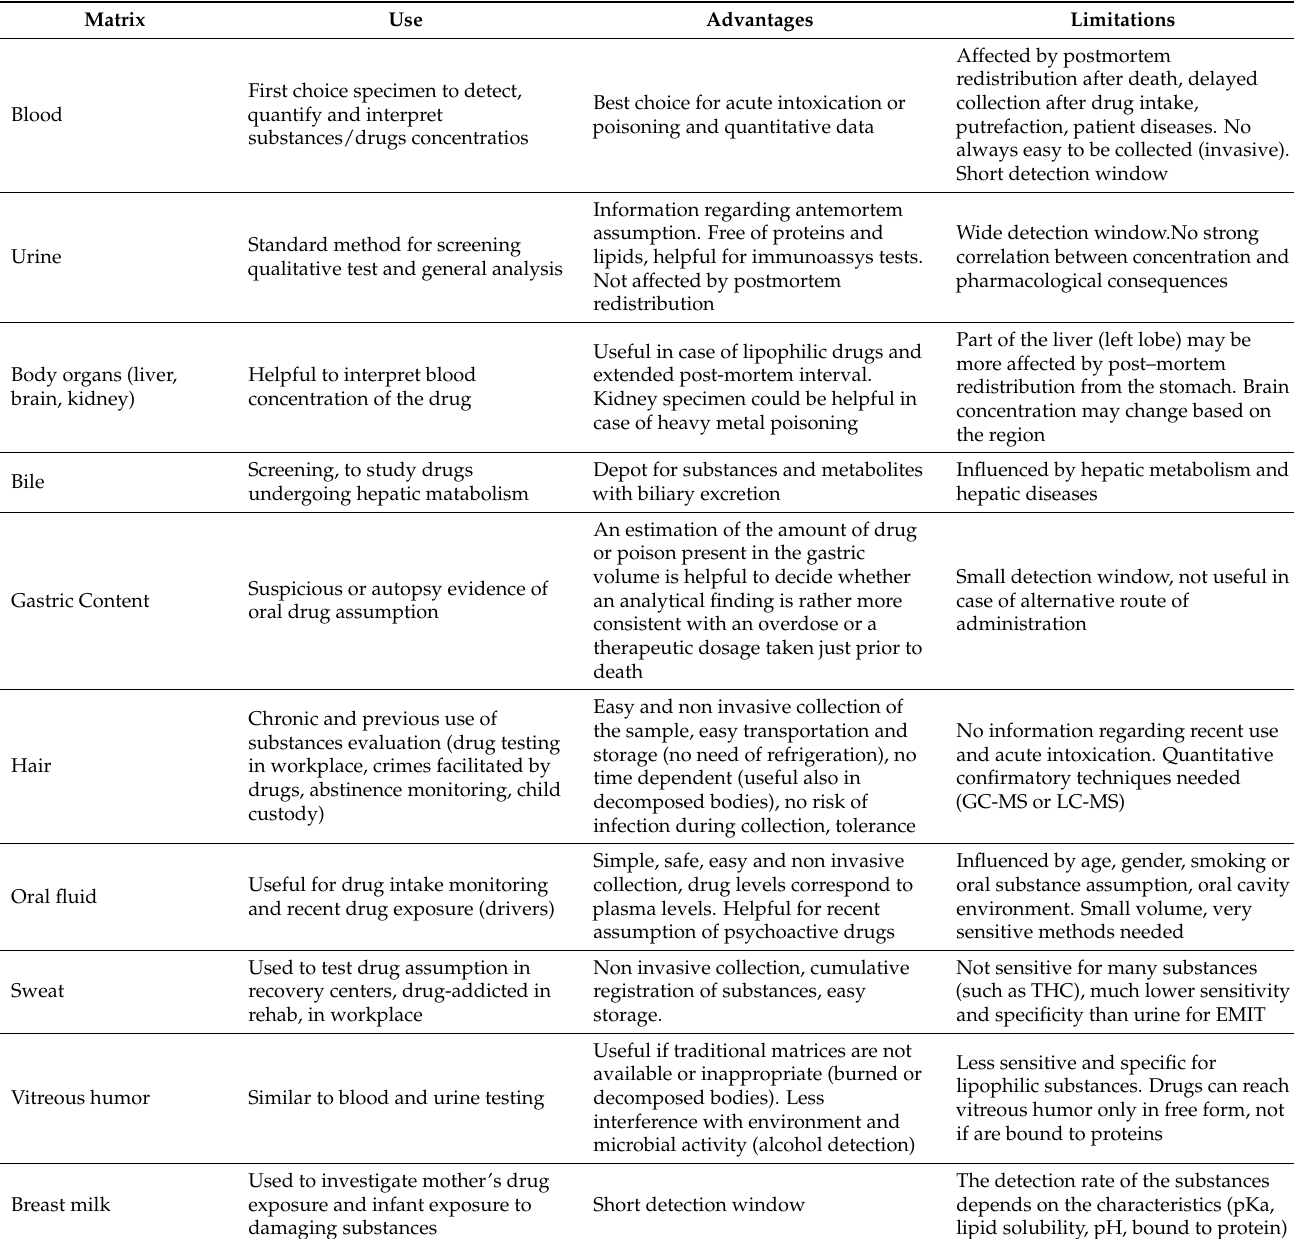
Table 3. Matrix properties, advantages, and limitations are